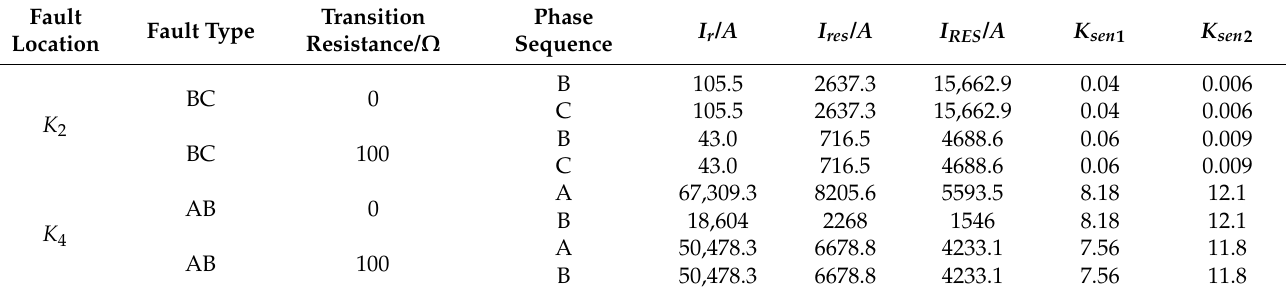
Table 2. Comparison of two-phase short-circuit simulation results of two algorithms. Fault